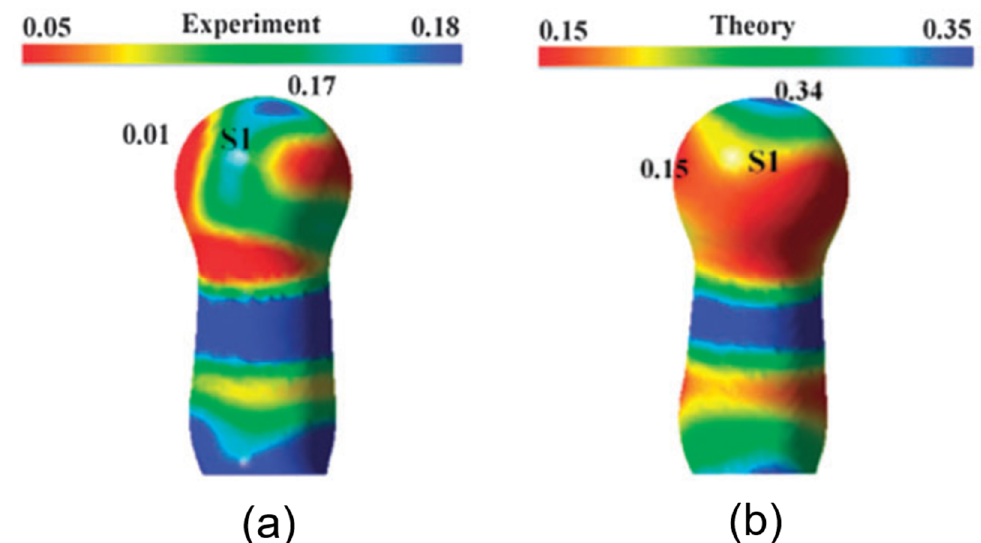
Figure 20. Electrostatic potential mapped on 0.5 eÅ − 3 isodensity surface; ( a ) highlights a σ -hole on S (blue) along the extension of the N=C=S bond, ( b ) highlights a π -hole (blue) perpendicular to the C=N bond. Blue and red colours: +ve (more electropositive) and –ve regions (less electropositive), respectively. (Figure reproduced from reference [90] ).